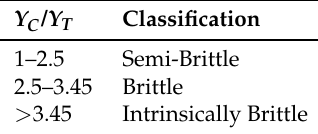
Table 2. Material classification according to different Y C / Y T ratios presented by Gu and Chen in [71].